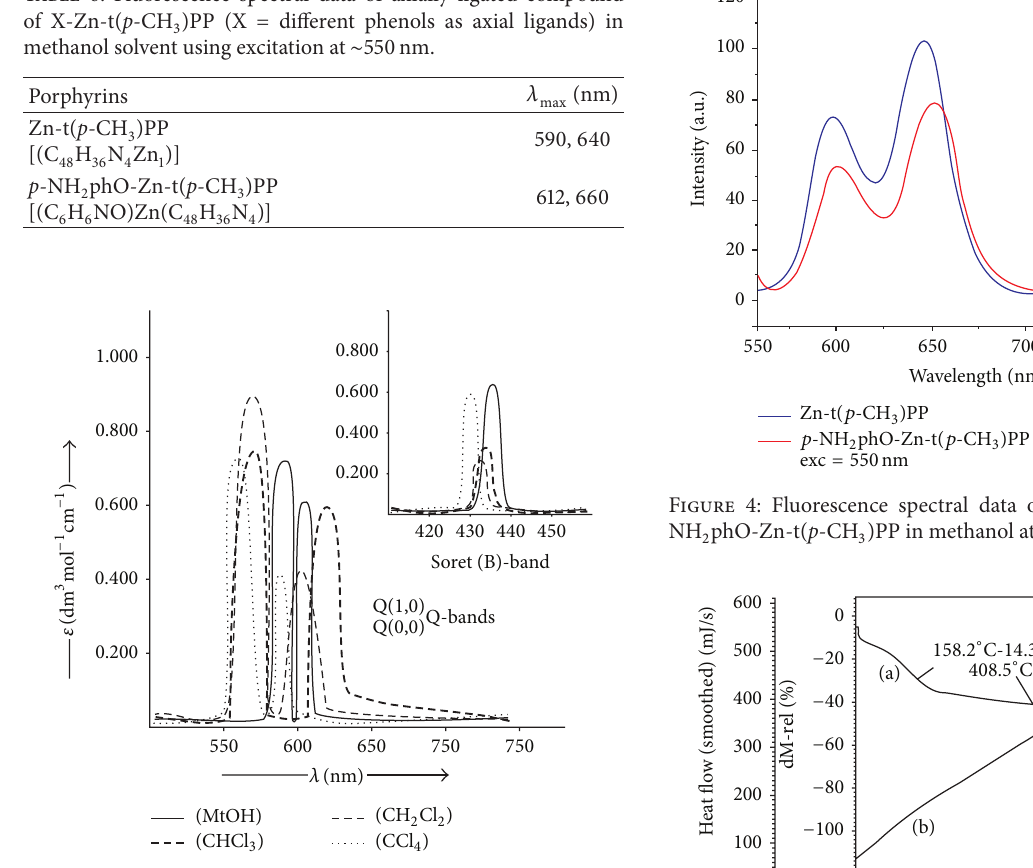
Figure 3: UV-Visible spectra of p -NH 2 phO-Zn-t( p -CH 3 )PP in different solvents.